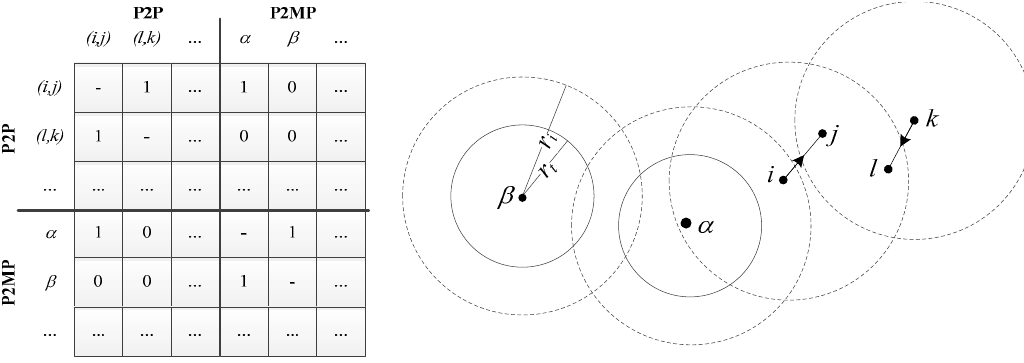
Figure 14. Example of conflict matrix ( left ); and a node disposition which produces it ( right ).